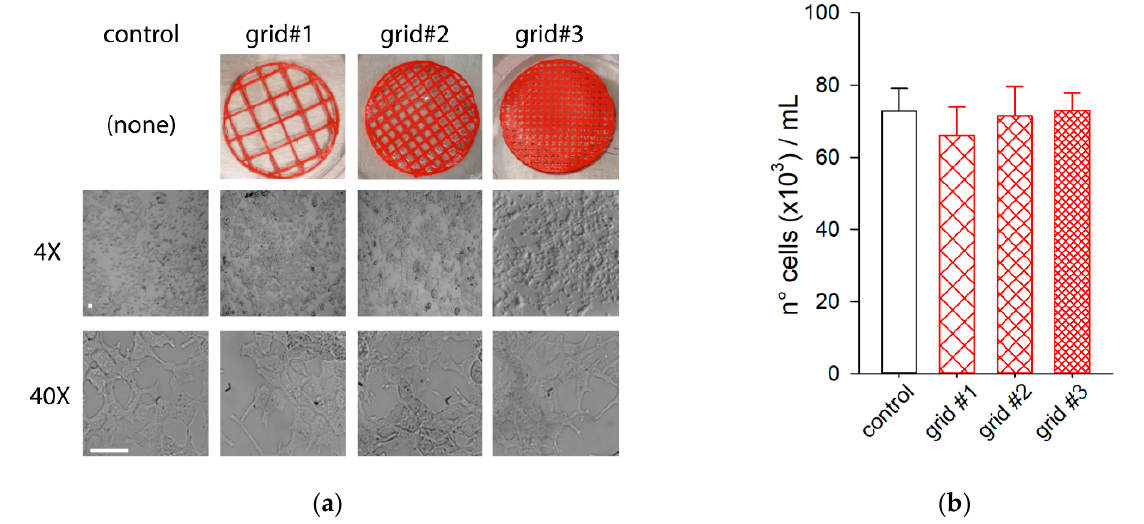
Figure 3. Cell culture outcomes: ( a ) Pictures illustrating the PLACTIVE TM -based grids used for the experiments (up) and representative images obtained from Hek-293 cell cultures in the absence or presence of grid, at 4× and 40× magnification (center and bottom, respectively, horizontal bar 50 µM); ( b ) Bar graphs representing the average values of the number of cells/mL under the different experimental conditions.